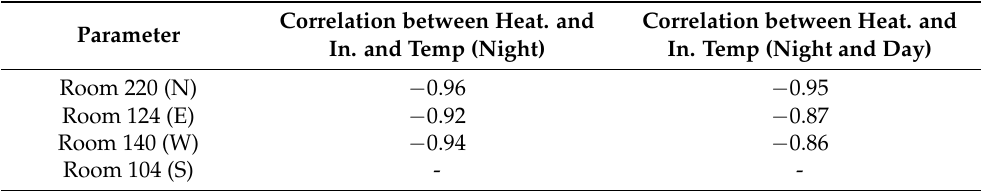
Table 9. Correlation coefficients between valve position and current value of room internal tempera- ture collected during night as well as night-and-day period.